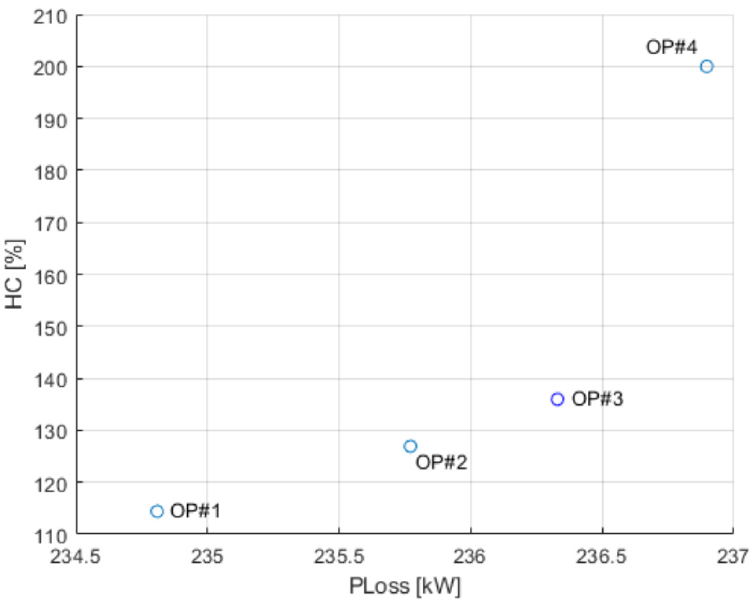
Figure 7. Pareto front of Case 1. Due to the probabilistic feature of the MOAIS search process, thirty runs were per- formed and the statistical results for the minimum obtained power loss are shown in Figure 8; which displays the median (272.05 kW). The lower and upper quartiles are 252.6 kW and 295.5 kW, respectively, which represents a deviation of around -7% to 9% in relation to the median; less than 10% in both directions. Only the power loss is evaluated in this case because the HC level is limited to 200%, and all of the thirty runs obtained a solution having this value.